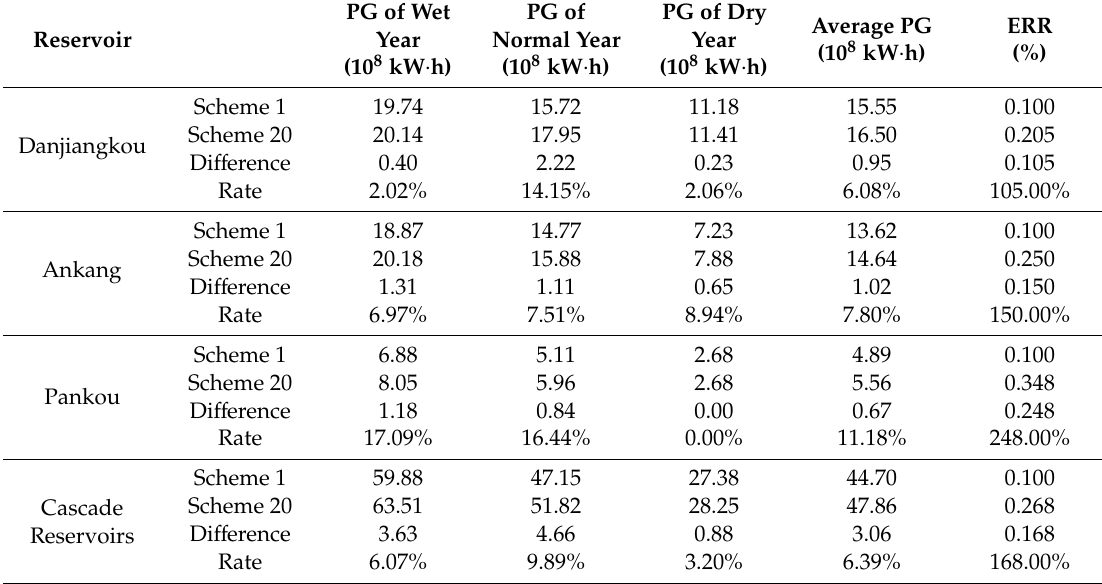
Table 4. Results comparison between scheme 1 and scheme